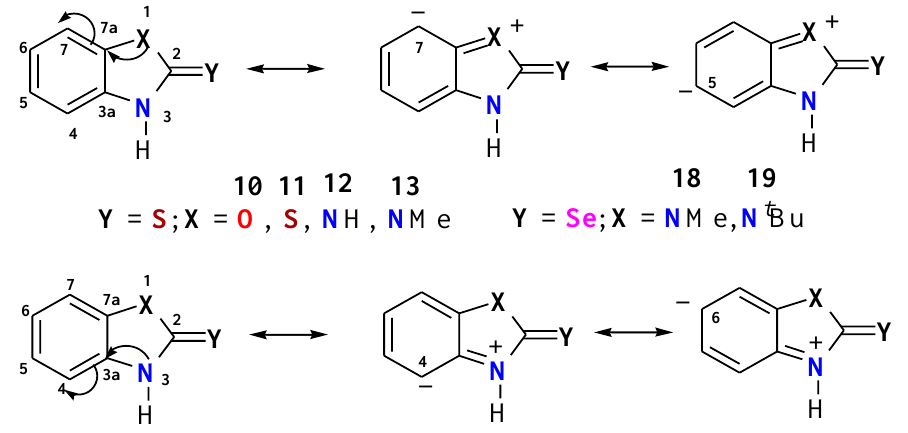
Figure 4. X and NH shielding electronic effect on the 1,3-benzazolidine-2-thione aromatic ring. In the 13 C-NMR spectrum of BOT 10 in CDCl 3 , the oxygen and nitrogen atoms exert a shielding electronic effect, shifting C7 to 110.5 ppm and C4 to 110.2 ppm. In this case, δ C4 δ C7 ref = 120.5 referenced to BO and ref = 109.6 ppm referenced to BIT 12 , and using Equation (2) for compound 10 with δ C4 obs = 110.2 resulted in 95% of the pyrrolic character. Then, the endocyclic nitrogen atom is mainly tautomer 10a , Table 6, near to that calculated by Balestrero et al. in 1986 [11]. In DMSOd 6 , δ C4 appeared at higher frequencies than in chloroform, because of the change in the tautomeric mixture of the pyrrole 10a (67%) and pyridine 10b (33%) character, evaluated through δ C4 obs = 113.2 ppm. In the same solvent, for BTT 11 , no considerable shielding electronic effect of sulfur atom was observed on C7 (121.6 ppm) compared with that of BT 2 (123.6 ppm). However, the nitrogen atom shifted C4 to 112.3 ppm compared with 121.8 ppm in BT 2 ( δ C4Nr), allowing to estimate 77% of pyrrole tautomer 11a . In the case of the TMBZs 14 , 15 , and 17 , their C4 observed values were found in 118.1, 121.7, and 117.4 ppm, respectively. Taking into account the C4 (119.1 ppm) and C7 (109.6 ppm) reference values, the proportion of their mesomeric form b with pyrrole negative nitrogen atoms was calculated as a minor proportion in 10.5%, 2.4%, and 17.9%, respectively, in DMSO-d 6 ; Table 6. Braun et al. [59] reported the synthesis of 1-EtBIT, analogous to compound 13 . A set of seven signals were found in the spectra of this compound in DMSOd 6 ; the chemical shifts of C3a and C7a are at 131.9 and 130.7, C4 and C7 are at 109.6/109.3, C5 and C6 in 122.2 and 122.1, and C2 = S at 167.6 ppm, respectively. We can see that the two nitrogen atoms are in pyrrole form, indicating the NH tautomer to be present in 100%. Palmer et al. [58] synthetized 1-alkylbenzimidazolidine-2-selenones (1-AkBISe) 18 and 19 and their corresponding diselenides 20 and 21 . In the X-ray diffraction structural analysis of 1-MeBISe 18 and 1- t BuBISe 19 , the hydrogen atom was located on the N atom (NH), demonstrating the structure to be the selenone tautomer. The density functional theory (B3LYP) calculations indicated that selenones are more stable than the selenol tautomers. Moreover, these data indicated that the selone is best represented as a C + –Se - zwitterion instead of as a C=Se double bond. This was confirmed in the 13 C-NMR spectrum obtained in DMSOd 6 (Table 7); both N1 and N3 atoms in 1-MeBISe 18 are mainly as pyrrole, producing the protecting effect on C4/C7 (110.0 ppm). Mesomer 18a was calculated in 95.8% in equilibrium with the mesomer 18b (4.2%). On the other hand, the t BuBISe 19 showed separate signals for C4/C7 (114.4/109.9 ppm), indicating, on this basis, the reference values (119.1 and 109.6 ppm) and, for C4 obs , the presence of mesomeric forms 19a / 19b in a 49.5/50.5 ratio. Eventually, mesomers 18c and 19c are present in a minor proportion. In the case of diselenides 20 and 21 , C7 in 120.4 and 118.8 ppm is indicative that NR atoms are principally the pyridine type. Then, their δ C4 chemical shifts at 110.5 and 114.1 ppm, respectively, show the pyridine character of N3. On the basis of these observed chemical shifts, mesomers 20a / 20b was calculated in a 90.5/9.5% ratio and 21a / 21b in